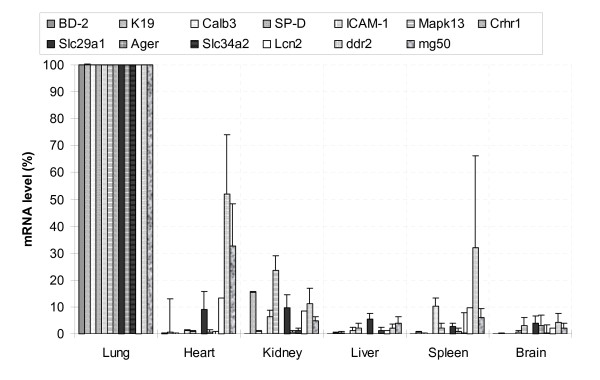
Relative mRNA abundance of lung-prominent genes determined by relative real-time PCR. The mRNAs from six organs were reverse-transcribed to cDNA and quantified by relative real-time PCR. All of the genes were run on the same plate with 18S rRNA as an endogenous reference. The results were expressed as % of lung. Data shown are means ± S.E. (n = 3 biological replications).The mRNA expression level of all the genes in the lung was significantly higher in other organs (P < 0.05).